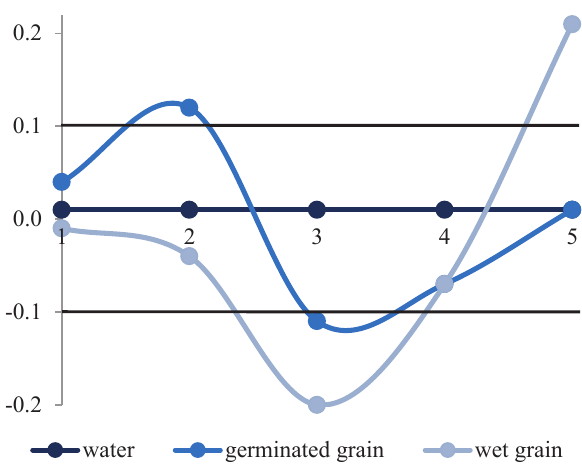
Figure 6 Absolute differences in identification parameters for grain samples compared to water. The X axis is the number of identification